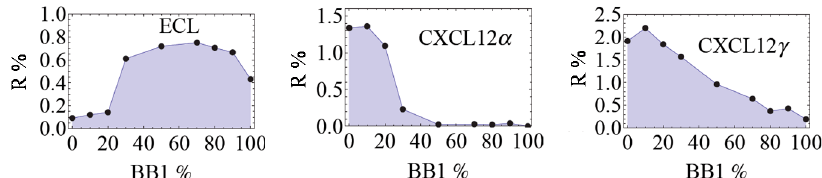
Figure 4. Discrimination of heparan sulfate binding proteins (HSbps) such as CXCL12 α and CXCL12 γ by the eT. 2D CEPs of ECL (200 nM) used as a non-HSbp for control, CXCL12 α and CXCL12 γ (both at 100 nM). Adapted from [26].